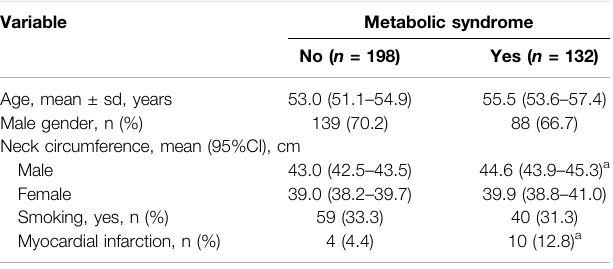
TABLE 5 | Multivariate logistic regression model with AHI as an dependent